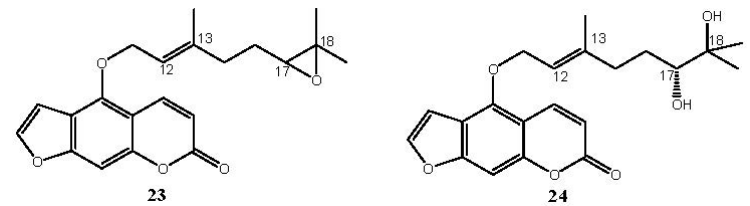
Figure 3. Chemical structures of bergamottin derivatives 23 and 24